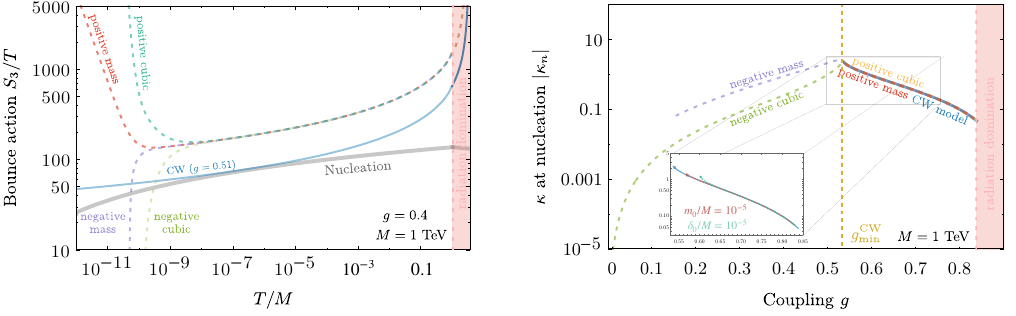
Figure 3 . The behavior of the nucleation condition in the different scenarios presented here complemented by the behavior of the κ parameter defined in eq. 3.3 at nucleation. For both panels, we fix M = 1 TeV . Left : the bounce action as a function of temperature in the different scenarios discussed here. The thick gray line is the R.H.S. of the nucleation condition in eq. (3.7). The blue line corresponds to the lower boundary of the supercooling window in the CW model ( g = 0 . 51 ). For the other curves we fix g = 0 . 4 . The violet (light green) curve shows for the effect of a non-thermal negative mass (cubic) with m 0 /M = 10 − 11 ( δ 0 /M = 10 − 11 ) which tends to enlarge the supercooling window. The red (sea-green) curve shows the effect of a positive non-thermal mass (cubic) deformation with m 0 /M = 10 − 11 ( δ 0 /M = 10 − 11 ) which instead tends to shrink the supercooling window. Right : the behavior of the κ parameter at nucleation ( κ n ) as a function of the gauge coupling. The zoomed-in region shows how the lower boundary of the supercooling window indicated by red (sea-green) points shrinks for positive mass (cubic) deformations which are larger enough. We take as an example m 0 /M = 10 − 5 ( δ 0 /M = 10 − 5 ) . √ MH simple analytical solution T n ' V